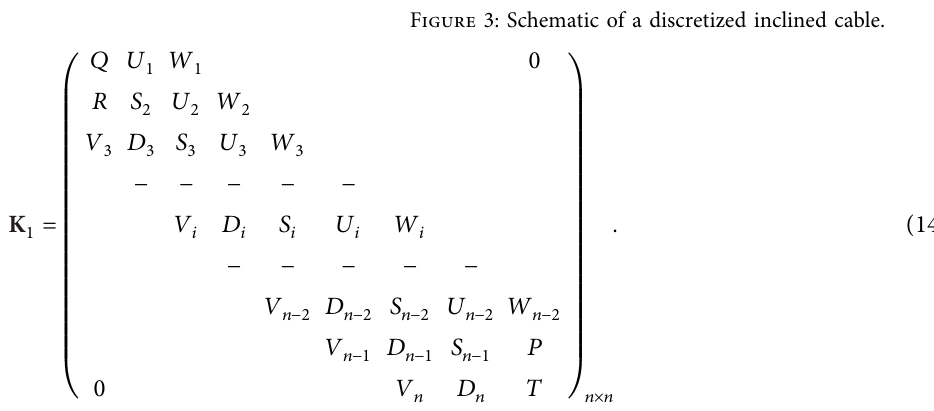
Figure 2: Schematic of an inclined cable.